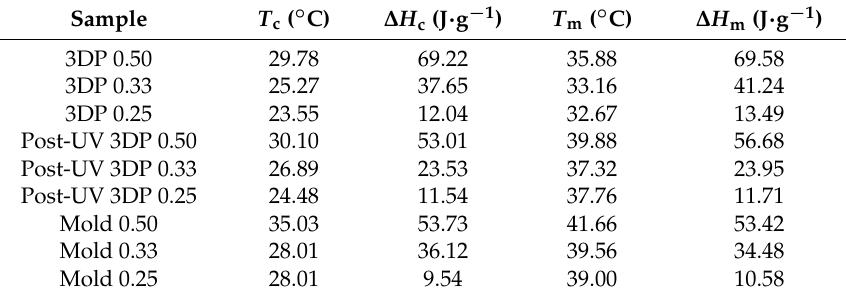
T c : crystallization temperature, ∆ H c : enthalpy of crystallization process, T m : melting temperature, ∆ H m : enthalpy of melting process. P(SA-DMAA) crystalline gels with molar fraction of SA at 0.50 had the highest energy storage capacity in higher temperature ranges than other samples, reached over 69 J · g − 1 . It is noted